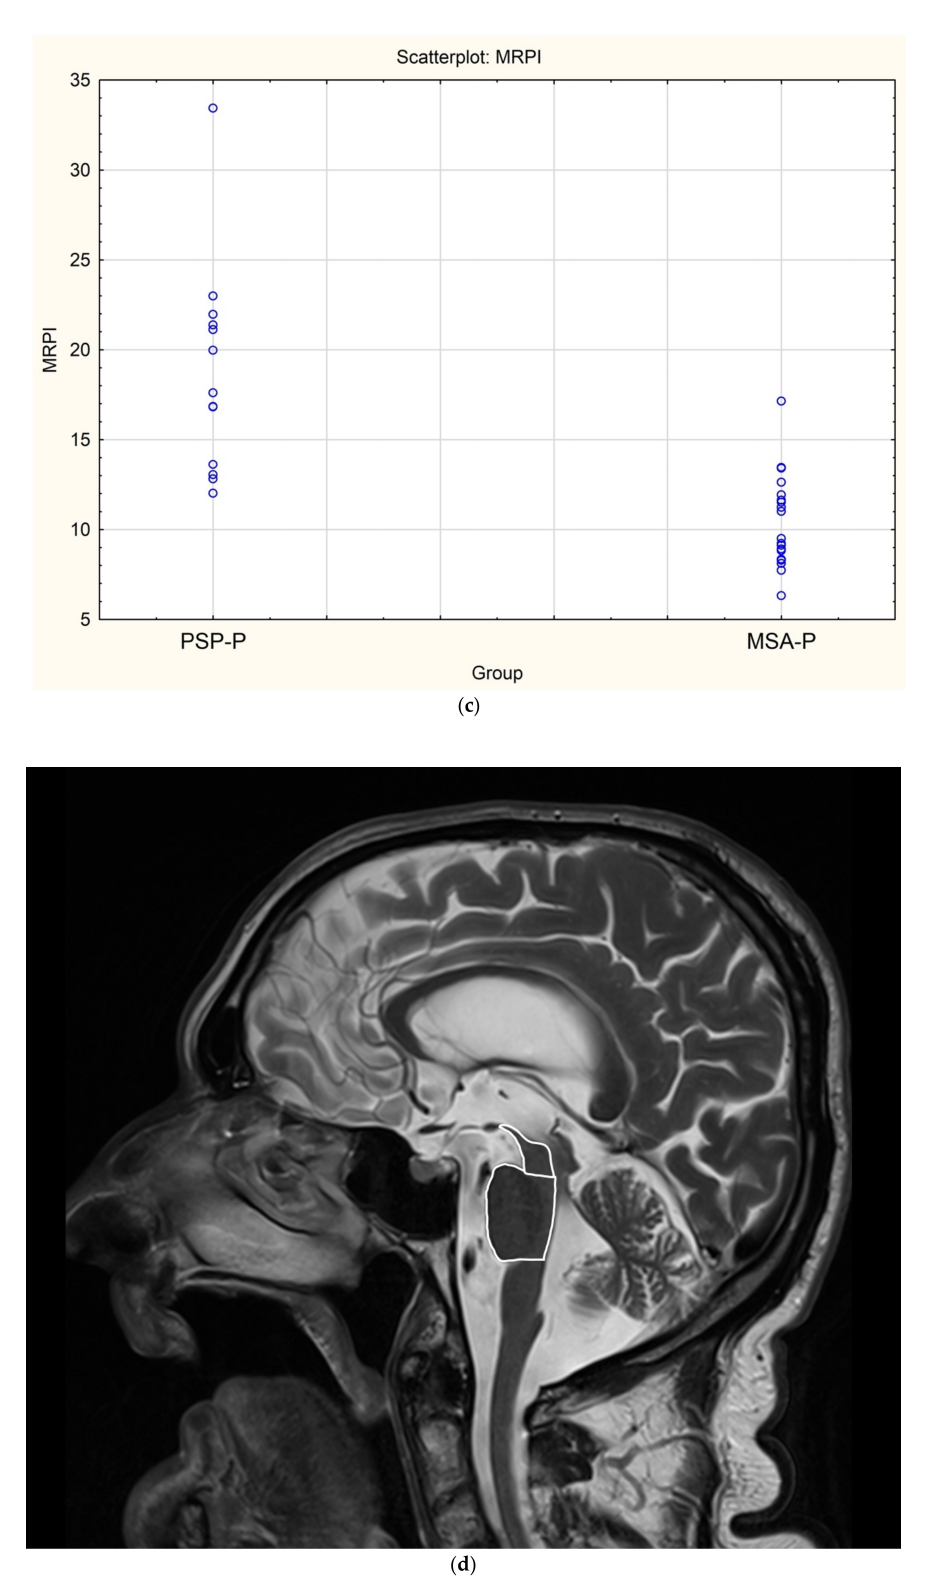
Figure 1. ( a ) . Scatterplot presenting the significant differences between MSA-P and PSP-P in the midbrain surface, ( b ) Scatterplot presenting the significant differences between MSA-P and PSP-P in the M/P ratio, ( c ) Scatterplot presenting the significant differences between MSA-P and PSP-P in the MRPI, ( d ) The atrophy of the mesencephalon in the MRI of a patient with